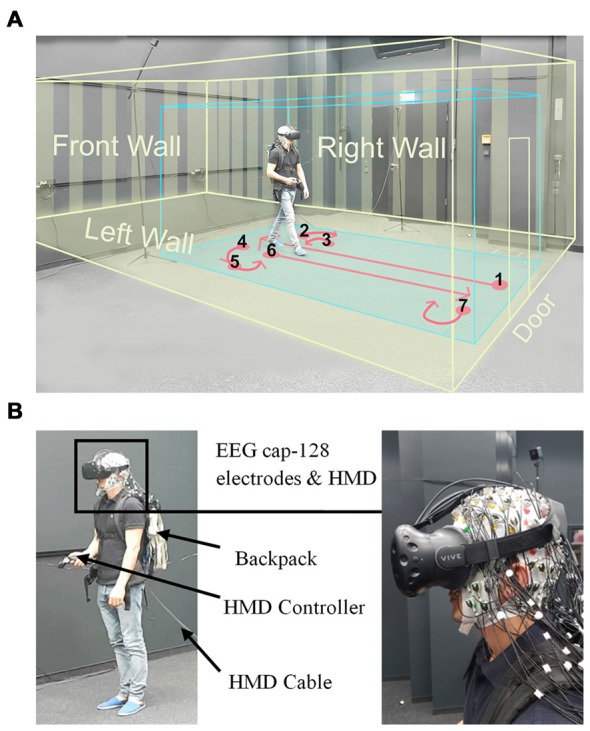
Experimental setup. (A) Displays a participant while walking inside the laboratory wearing a head-mounted VR display (HTC Vive), the virtual room, and an electroencephalogram (EEG) cap. The participant provided written consent that the video recordings may be used in scientific publications. The blue box displays the borders of the walking space and the yellow box indicates the dimensions of the virtual room. The instructed walking paths are marked in red and all the walls and the door of virtual room are displayed in yellow. (B) Left: displays a participant wearing the head-mounted display (HMD; HTC Vive) and holding a controller in his hand. The EEG transmission systems were located in a backpack. The HMD cable was connected to the rendering PC and was extended to allow free movement of participants, Right: close view on the HMD place on an electrode cap with 128 actively amplified electrodes.